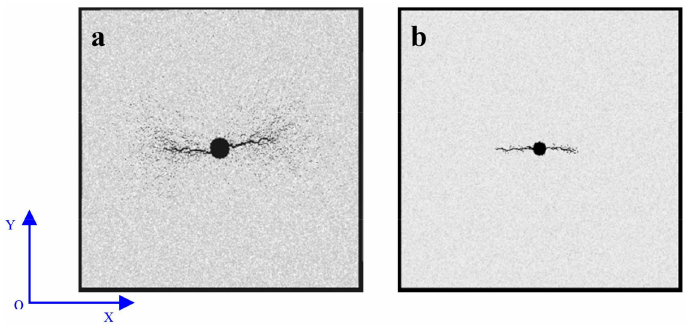
Figure 8. Hydraulic fracture (HF) geometries. ( a ) Corresponds to Case I ( m = 2.0); ( b ) corresponds to Case II ( m =